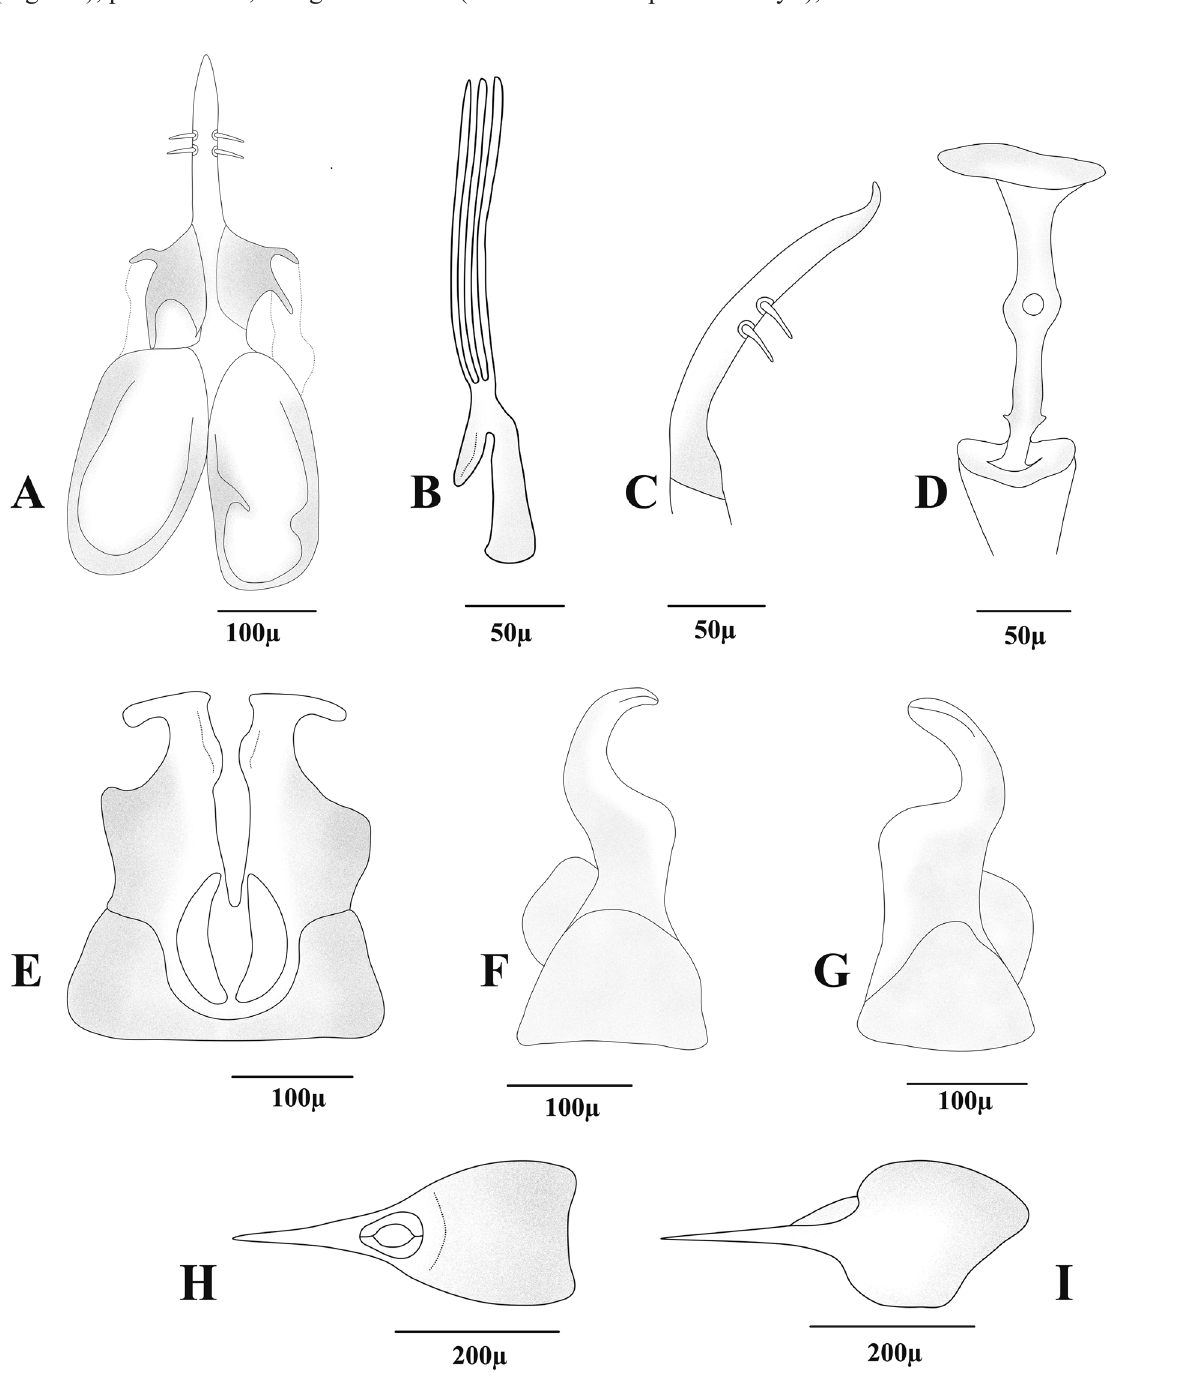
Fig. 5. Terminalia of Dasydorylas zardouei Motamedinia & Kehlmaier sp. nov. A–G . ♂, holotype. A . Phallic guide, gonopods and hypandrium in ventral view. B . Distiphallus with ejaculatory ducts in lateral view. C . Phallic guide in lateral view. D . Ejaculatory apodeme. E . Surstyli in dorsal view. F . Left surstylus in lateral view. G . Right surstylus in lateral view. – H–I . ♀, paratype. H . Ovipositor in dorsal view. I . Ovipositor in lateral